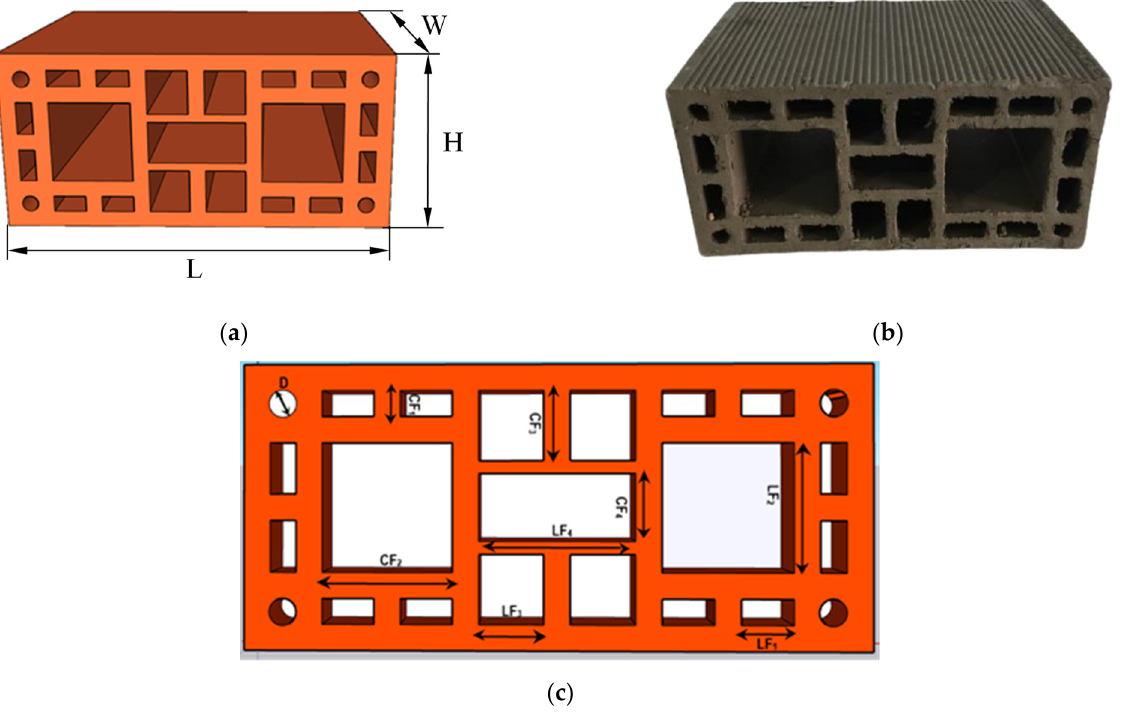
Figure 1. Structural ceramic block. ( a ) 3D drawing. ( b ) Photograph of the wet material. ( c ) Front view indicating the main dimensions of the material.